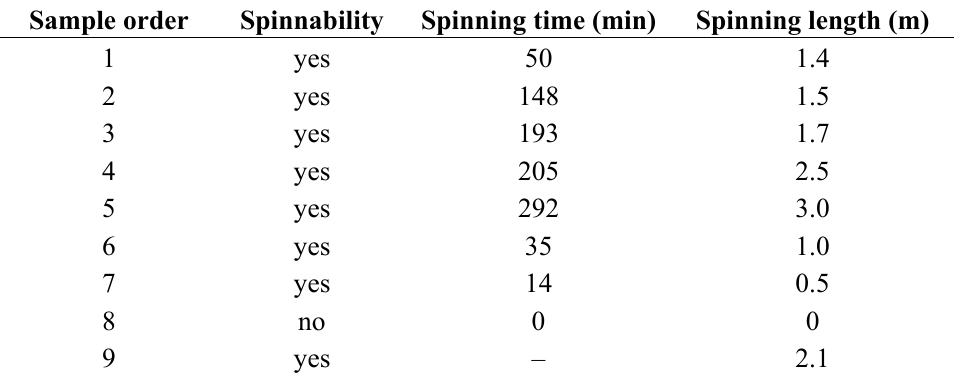
Table 2. Spinnability of the hybrid